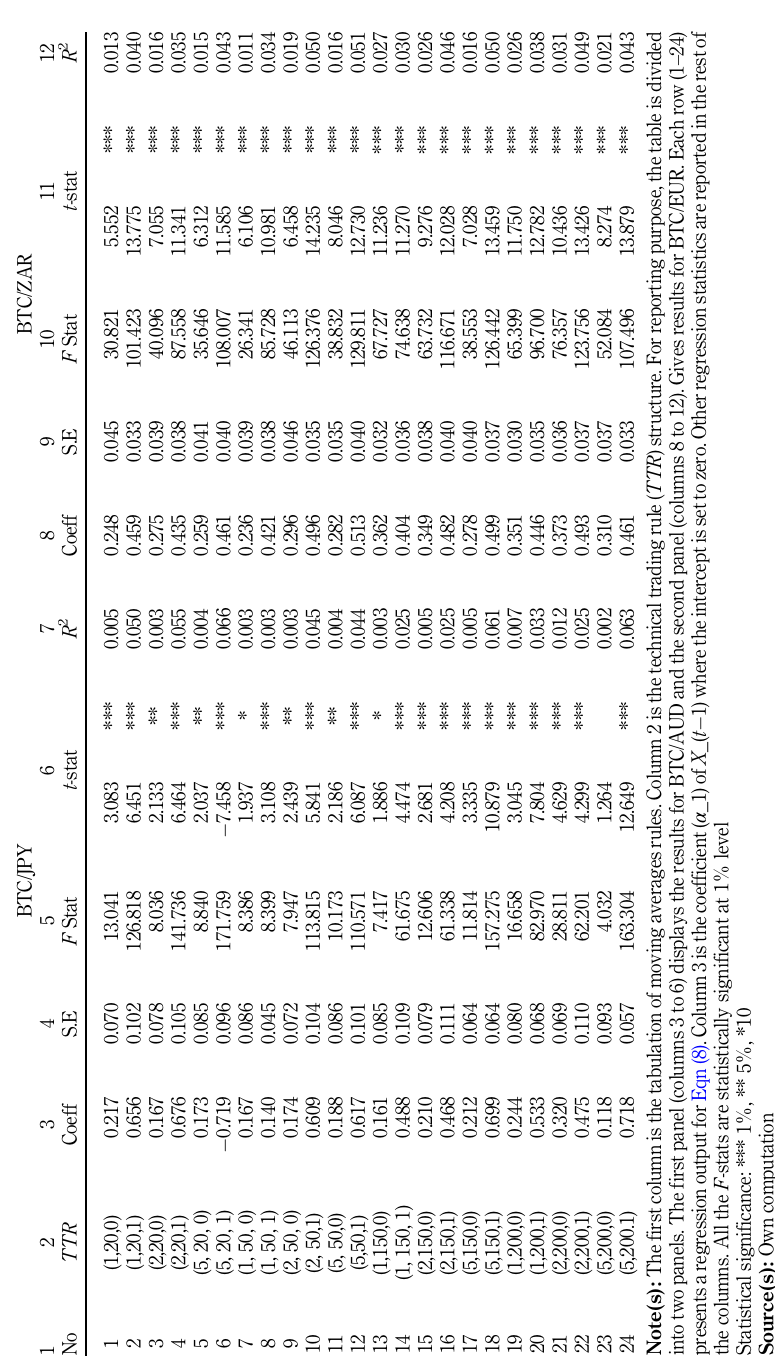
Table 7. Kho ’ s buy – sell